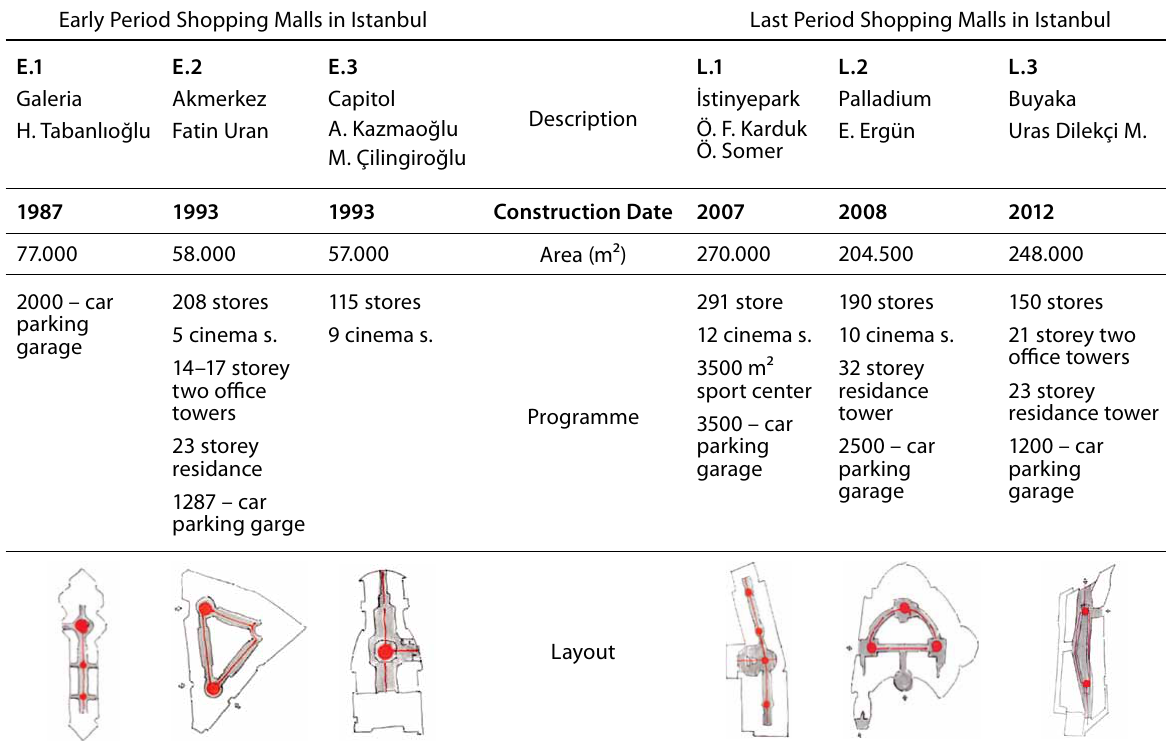
Table 1. Shopping Malls (Early Period/last